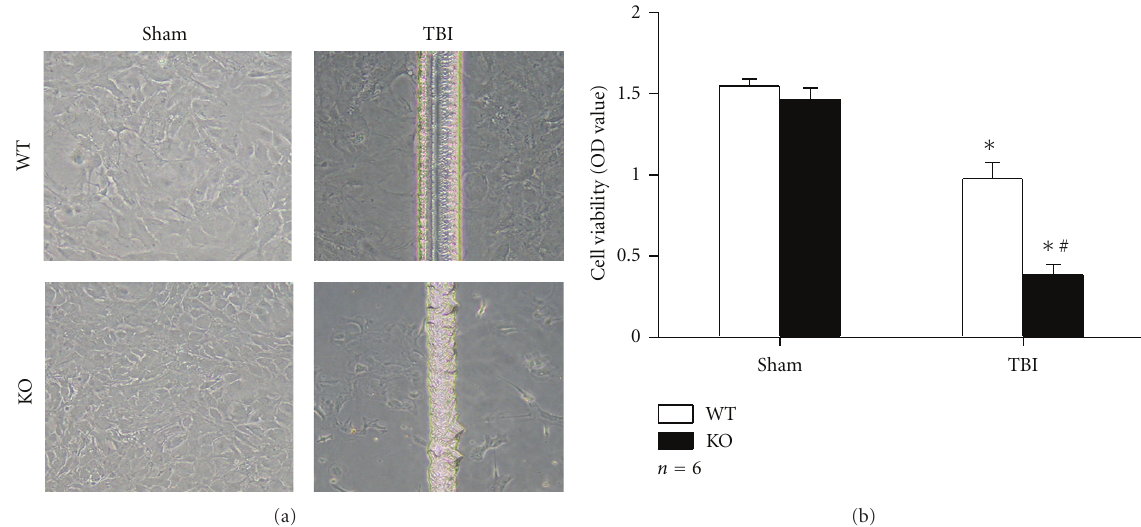
Figure 1: Loss of Nrf2 enhanced cell death after scratch. (a) Cultured astrocytes scratched or not were observed under microscope ( × 100). There was more cell death in group KO TBI. (b) CCK-8 analysis revealed lower OD value in scratched astrocytes ( P < 0 . 01). Group KO TBI showed significant lower OD value than group WT TBI ( P < 0 . 01). ( ∗ P < 0 . 01, compared with sham counterpart; # P < 0 . 01, compared with WT TBI).